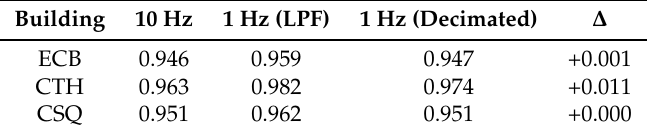
Table 4. Average ρ max for the coexistent KU traces before and after